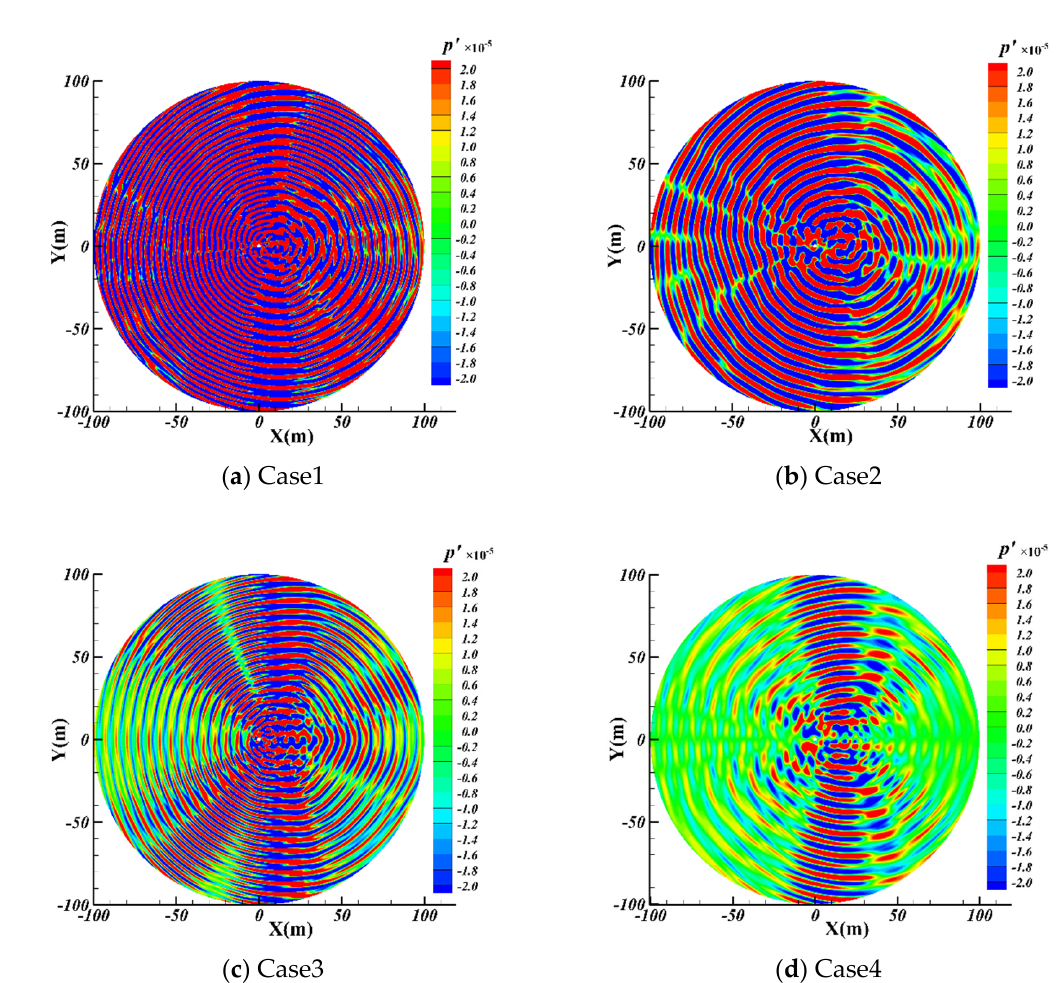
Figure 16. Snapshots of the sound pressure filed.